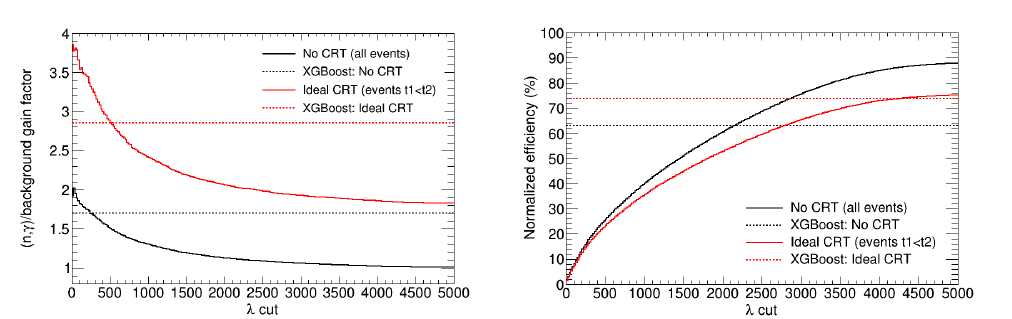
Figure 4. Relative SBR gain factor (left) and relative (n, γ ) (right) as a function of λ max . The reference SBR = 1 and e ffi ciency = 100% correspond to i-TED (S&A) with no imaging selection. The black and red solid lines correspond to the analytical imaging case with no time resolution and ideal coincidence-resolving time (CRT), respectively. The dashed lines show the results obtained with XGBoost (constant values since the λ cut does not apply).